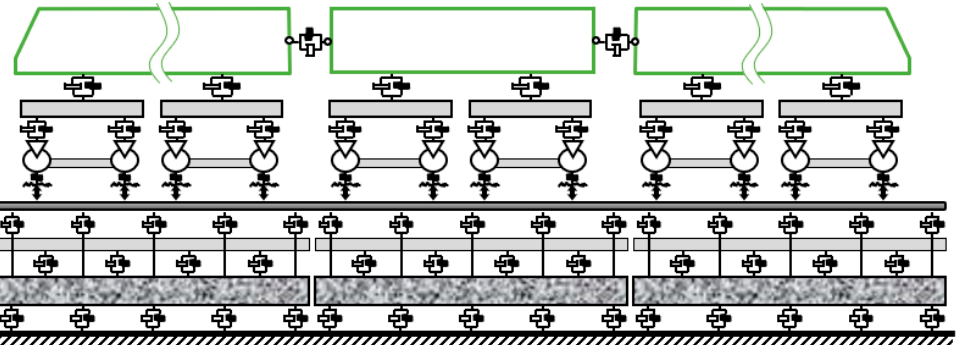
Figure 2. LIM subway vehicle-track coupling dynamic six-group model.